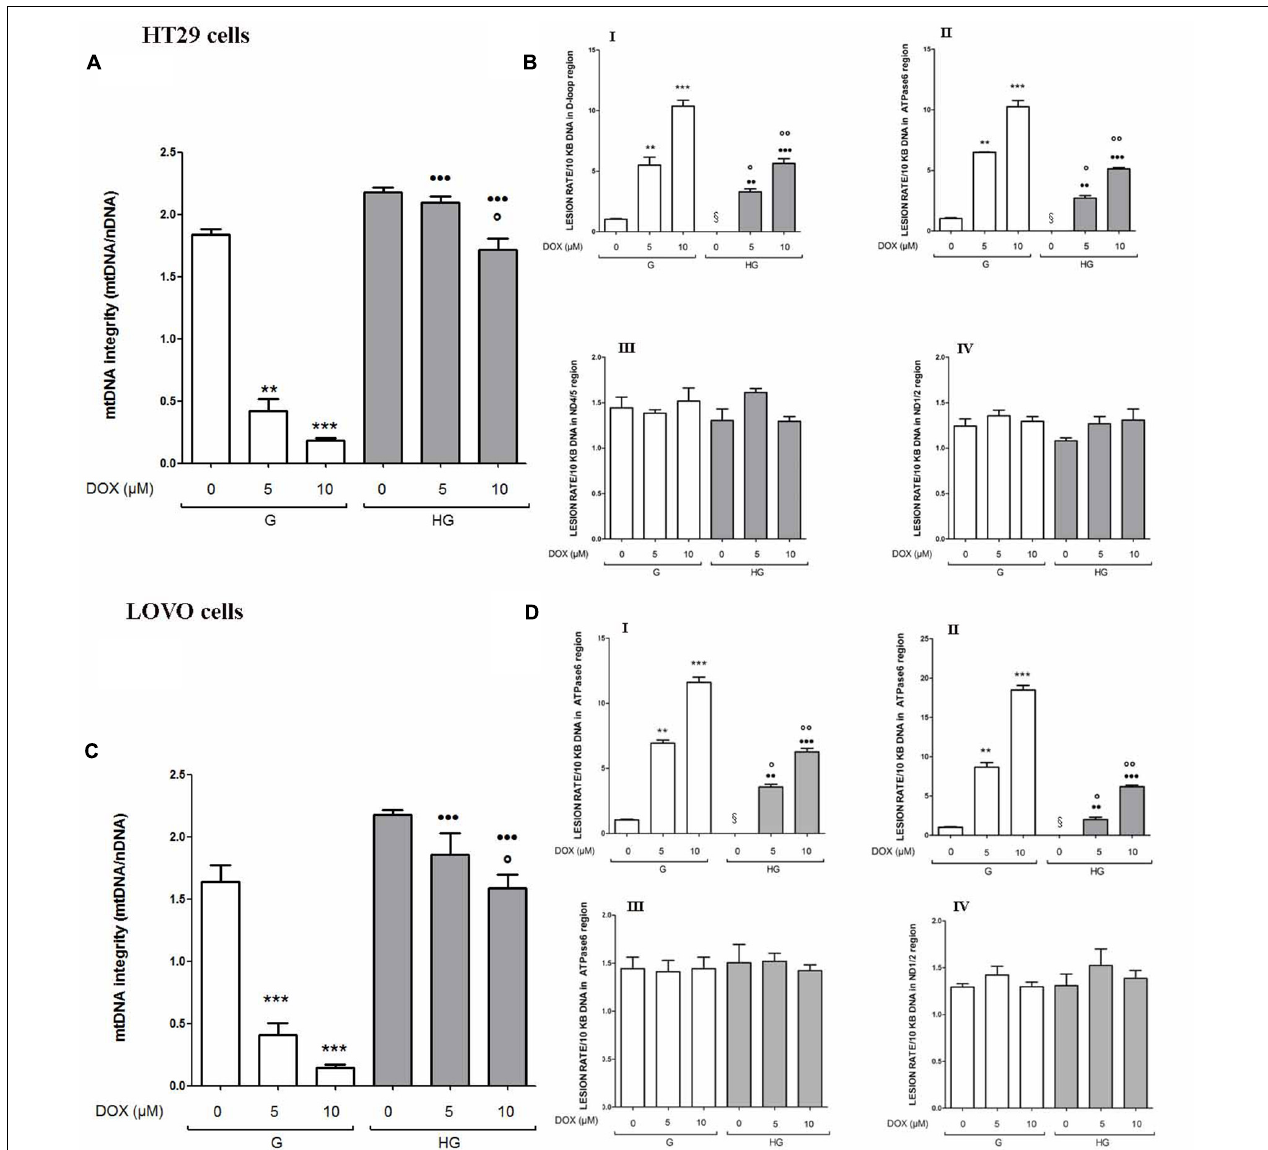
FIGURE 4 | Effect of normal glucose (G) and high glucose (HG) on mitochondrial DNA damage (mtDNA) in absence or presence of DOX in human colon cancer (HT29 and LOVO) cells. Cells were cultured for ≥ 7 days in the presence of G and HG, incubated for 24 h before analysis with 5 and 10 µ M DOX, then washed and processed to determine the mtDNA integrity by qRT-PCR and the lesion rate by semi-long run rt-PCR (SLR rt-PCR). Measurements ( n = 6) were performed in triplicate. (A) For mtDNA integrity measurements: ∗∗ p < 0.001 and ∗∗∗ p < 0.0001, respectively, 5 and or 10 µ M DOX in HT29 cells cultured in G vs. 0 µ M DOX in HT29 cells cultured in G; ◦ p < 0.00 10 µ M DOX in HT29 cells cultured in HG vs. 0 µ M DOX in HT29 cells cultured in HG; ••• p < 0.0001 5 and or 10 µ M DOX in HT29 cells cultured in HG vs. 5 and or 10 µ M DOX in HT29 cells cultured in G. (C) ∗∗∗ p < 0.0001, 5 and or 10 µ M DOX in LOVO cells cultured in G vs. 0 µ M DOX in LOVO cells cultured in G; ◦ p < 0.00 10 µ M DOX in LOVO cells cultured in HG vs. 0 µ M DOX in LOVO cells cultured in HG; ••• p < 0.0001 5 and or 10 µ M DOX in LOVO cells cultured in HG vs. 5 and or 10 µ M DOX in LOVO cells cultured in G. (B,D) For lesion rate measurements: ∗∗ p < 0.001 and ∗∗∗ p < 0.0001, respectively, 5 and or 10 µ M DOX in HT29/LOVO cells cultured in G vs. 0 µ M DOX in HT29/LOVO cells cultured in G; § p < 0.01 0 µ M DOX in HT29/LOVO cells cultured in HG vs. 0 µ M DOX in HT29/LOVO cells cultured in G; ◦ p < 0.01 and ◦◦ p < 0.001, respectively, 5 and 10 µ M DOX in HT29/LOVO cells cultured in HG vs. 0 µ M DOX in HT29/LOVO cells cultured in HG; •• and ••• p < 0.0001, respectively, 5 and or 10 µ M DOX in HT29/LOVO cells cultured in HG vs. 5 and or 10 µ M DOX in HT29/LOVO cells cultured in